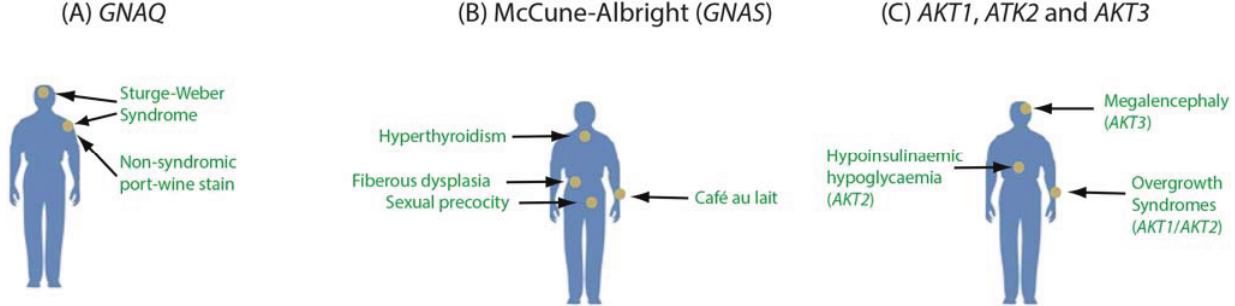
Figure 2. Tissue-specific effects of mutations in GNAQ ( A ); GNAS ( B ); and AKT1 , AKT2 , and AKT3 ( C ). Constitutively activating mutations in GNAQ may lead to either Sturge-Weber syndrome, nonsyndromic port-wine stains, or uveal melanoma ( A ). Somatic activating mutations in GNAS lead to McCune-Albright syndrome, which may involve variable hyperthyroidism, café au lait macules and sexual precocity ( B ). Activating mutations in all three of the AKT genes cause cellular overgrowth phenotypes with mutations in AKT2 also implicated in abnormal insulin signaling ( C